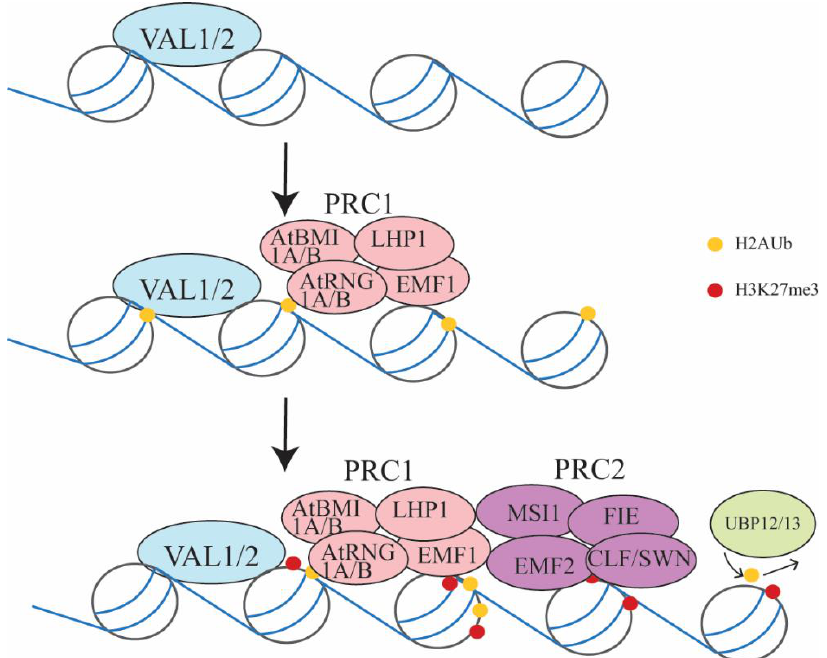
Figure 2. Model of PRC1 and PRC2 during embryo-to-seedling transition. Recruitment of VAL1/2 to the chromatin of LEC1/LEC2/ABI3/FUS3 or other targets to mediate binding of PRC1 via interaction with the AtBMI1A/B complex. PRC1 ubiquitinates H2A and recruits PRC2 via binding of MSI1 (a PRC2 component) to EMF1/LHP1(PRC1 component), leading to increased levels of H3K27me3 at LEC1/LEC2/ABI3/FUS3 and other genes. UBP12/13 removes ubiquitin from target sites to allow binding of PRC2 and stable silencing.